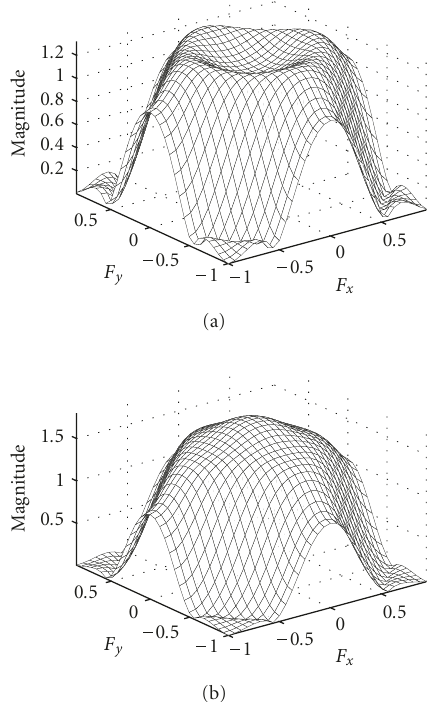
Figure 8: Frequency responses of the (a) lowpass analysis and (b) lowpass synthesis filters of